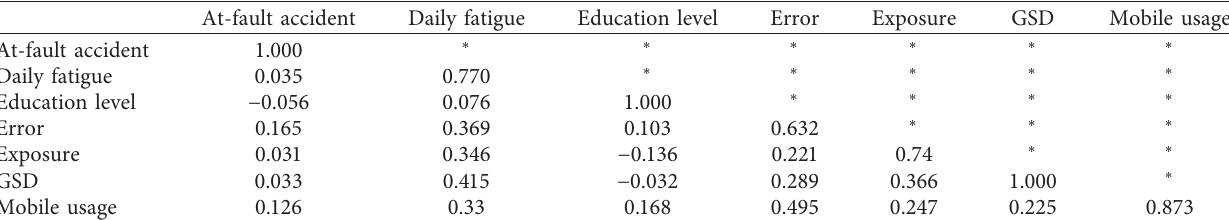
Table 2: Fornell-Larker test results.